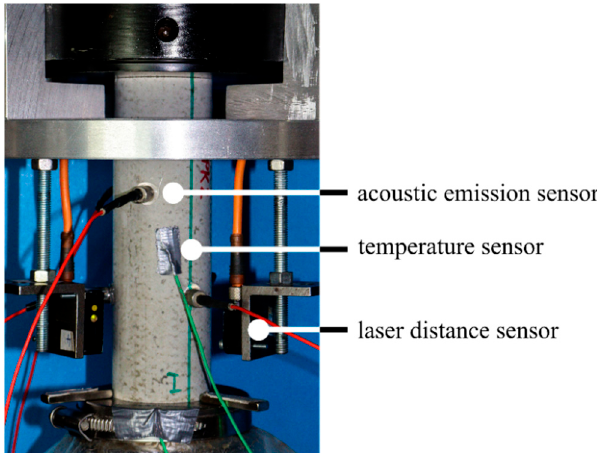
Figure 3. Experimental set-up.